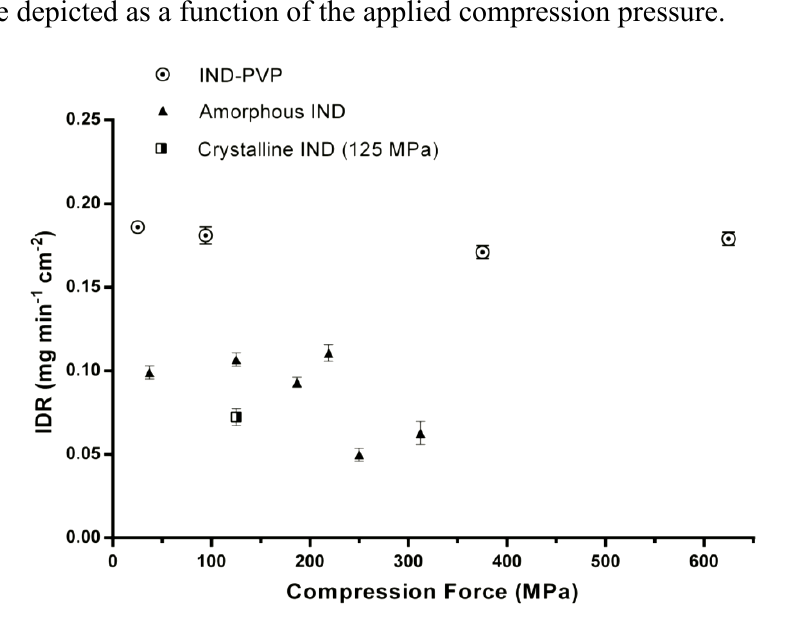
Figure 6. IDRs of IND–PVP, amorphous (milled) IND and crystalline IND compacts. The IDRs are depicted as a function of the applied compression